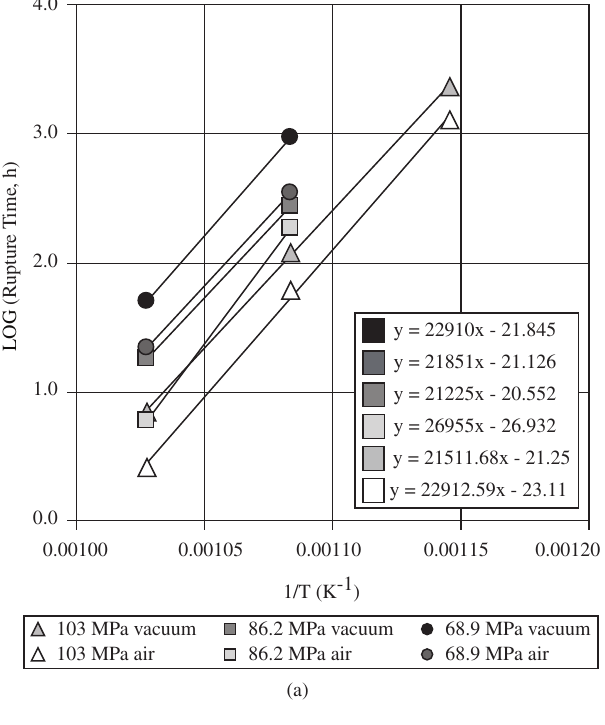
also in agreement with the work reported by Glen 8 on ½CrMo and 1CrMo steels which indicates that the lower the test temperature the the corresponding value in rupture strain.